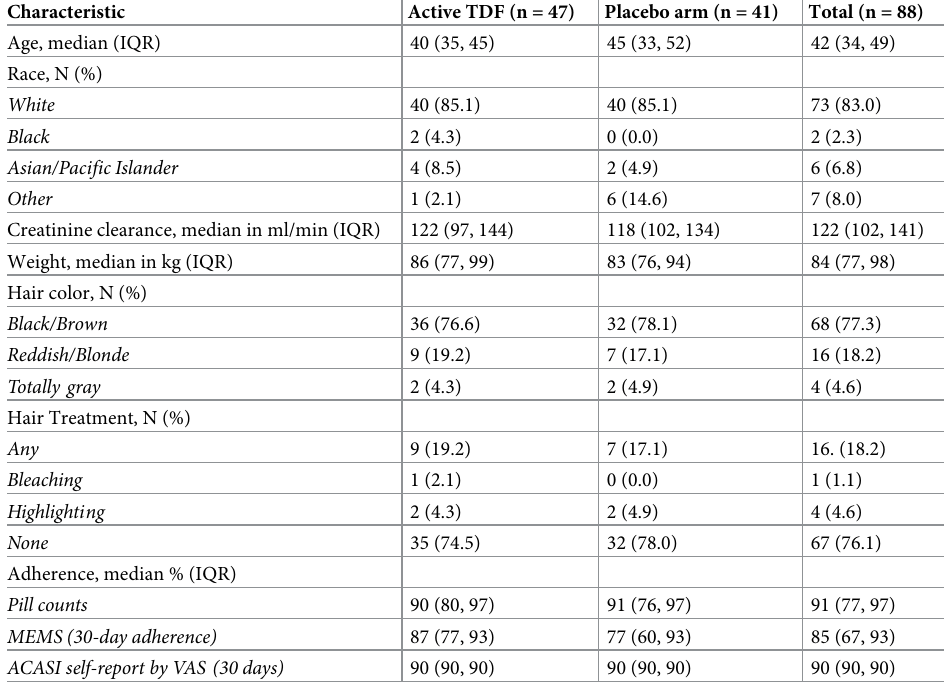
Table 1. Baseline characteristics of participants in the active and placebo participant arms of the US CDC PrEP safety study. Characteristic Active TDF (n = 47)